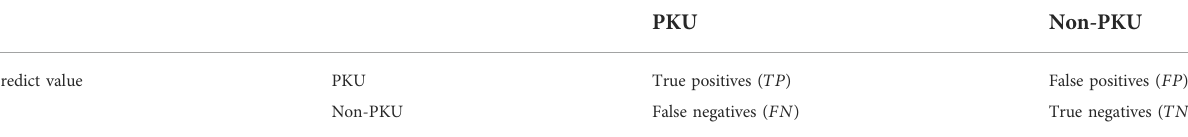
TABLE 1 Confusion matrix.